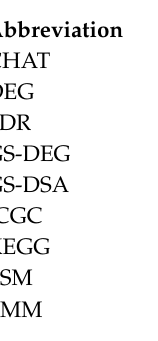
Figure S1: Heatmap with the simulation of the e ff ect of the drug on the circuits, Table S1: Drugs that are used for each cancer in the simulation; Table S2: Circuits a ff ected by the action of the di ff erent indicated drugs used in each cancer. Table S3: Results of the simulations of drug e ff ects over any individual circuit for the drugs with targets within the corresponding